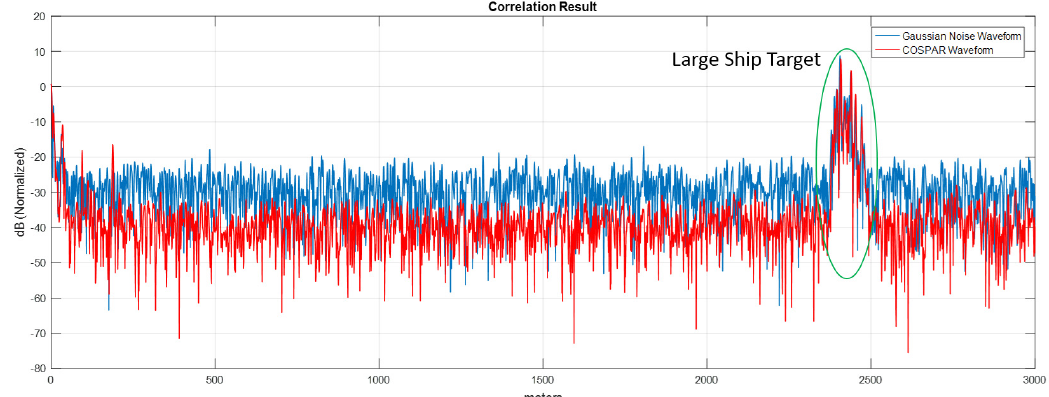
Figure 19. Comparison of range profiles of the ship target for Gaussian noise and COSPAR waveform. COSPAR provides more room for better target SNR by having lower sidelobes than Gaussian noise.